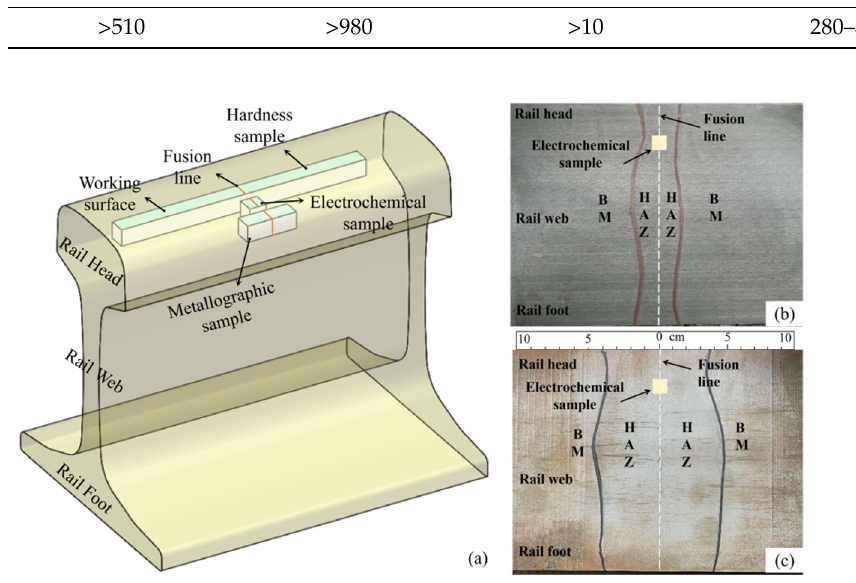
Figure 2. Schematic of the joint: ( a ) Schematic of sample cutting; cross ‐ section morphology of the ( b ) URWJB and ( c )